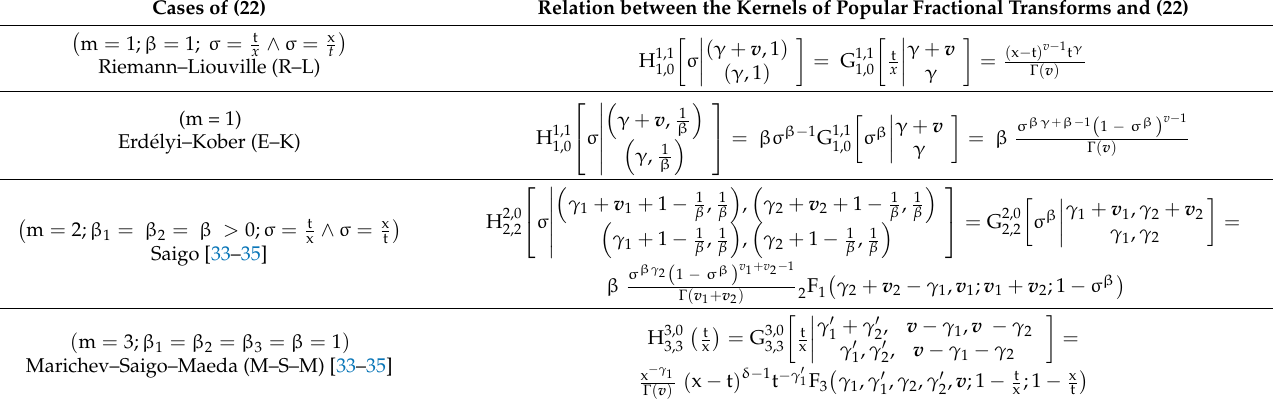
Table 1. Important cases of Kiryakova’s fractional operators